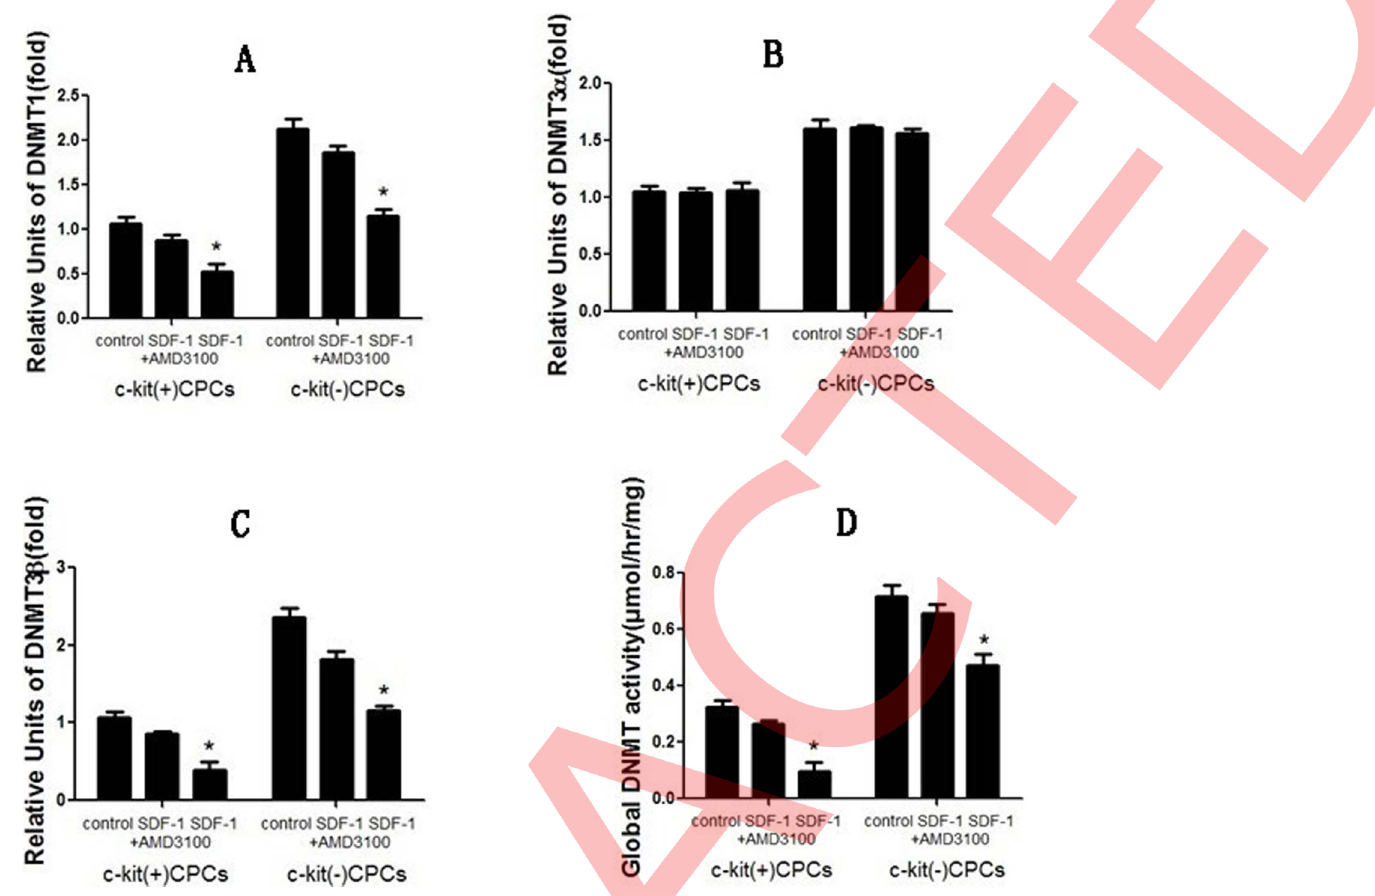
Figure 4. SDF-1 a inhibition on the expression and activity of DNMT. (A) CPCs were stimulated with 100 ng/ml SDF-1 a and 5 m g/ml AMD3100 for 48 h. qPCR was used to determine the relative DNMT1 mRNA levels. (B) qPCR was used to determine the relative DNMT3 a mRNA levels. (C) qPCR was used to determine relative DNMT3 b mRNA levels. (D) EpiQuik DNMT activity assay kit was used to analyze the global DNMT activity. Data were obtained from three independent experiments and expressed as mean 6 SD. n=3.rol group.n of cit and GAPHD.0.Western blot wa c-kit at both protein and mRNA level * P , 0.05 versus the control group.